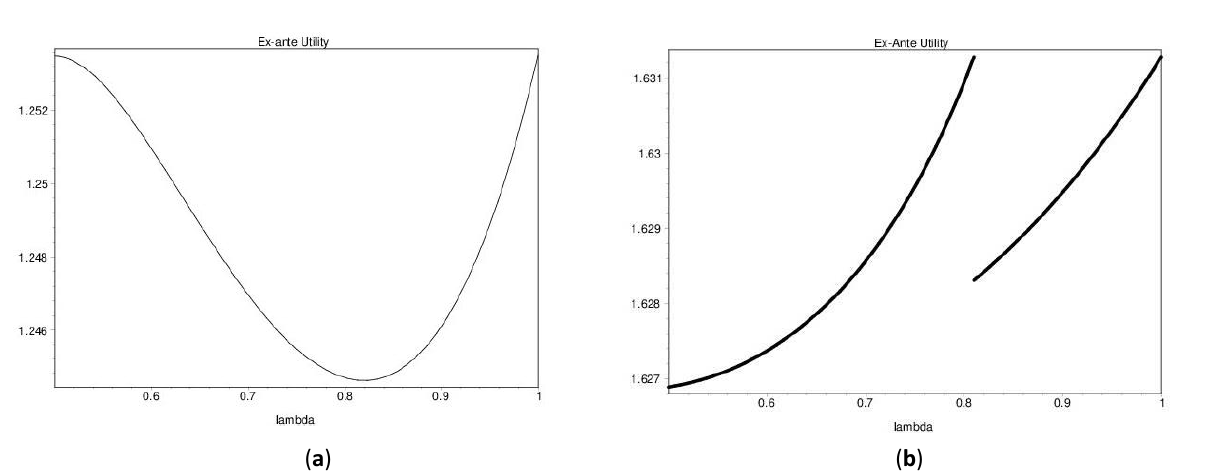
Figure 2. Effect of segregation on aggregate welfare (multiple optima). ( a ) Parameters: θ L = 1, θ H = 1 . 5, π = 0 .7 6, a=0.5, − k i ) = 0. ( b ) Parameters: θ L = 1, θ H = 1 . 5, π = 0 . 8, ( k ¯ a=0.4, a ( k ¯ − k i ) =